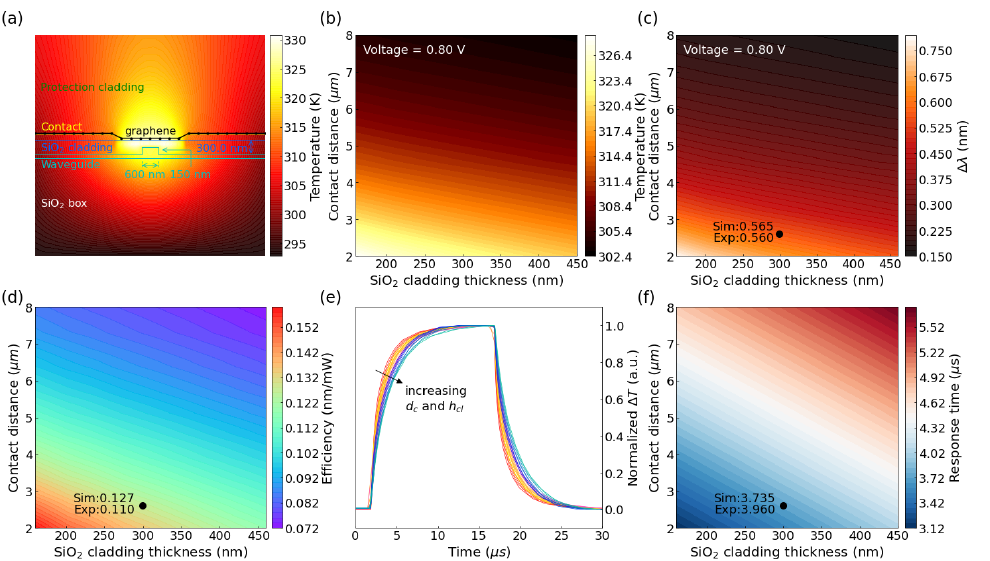
Table 1. Performance comparison of some silicon TO devices working at 2 μ m.